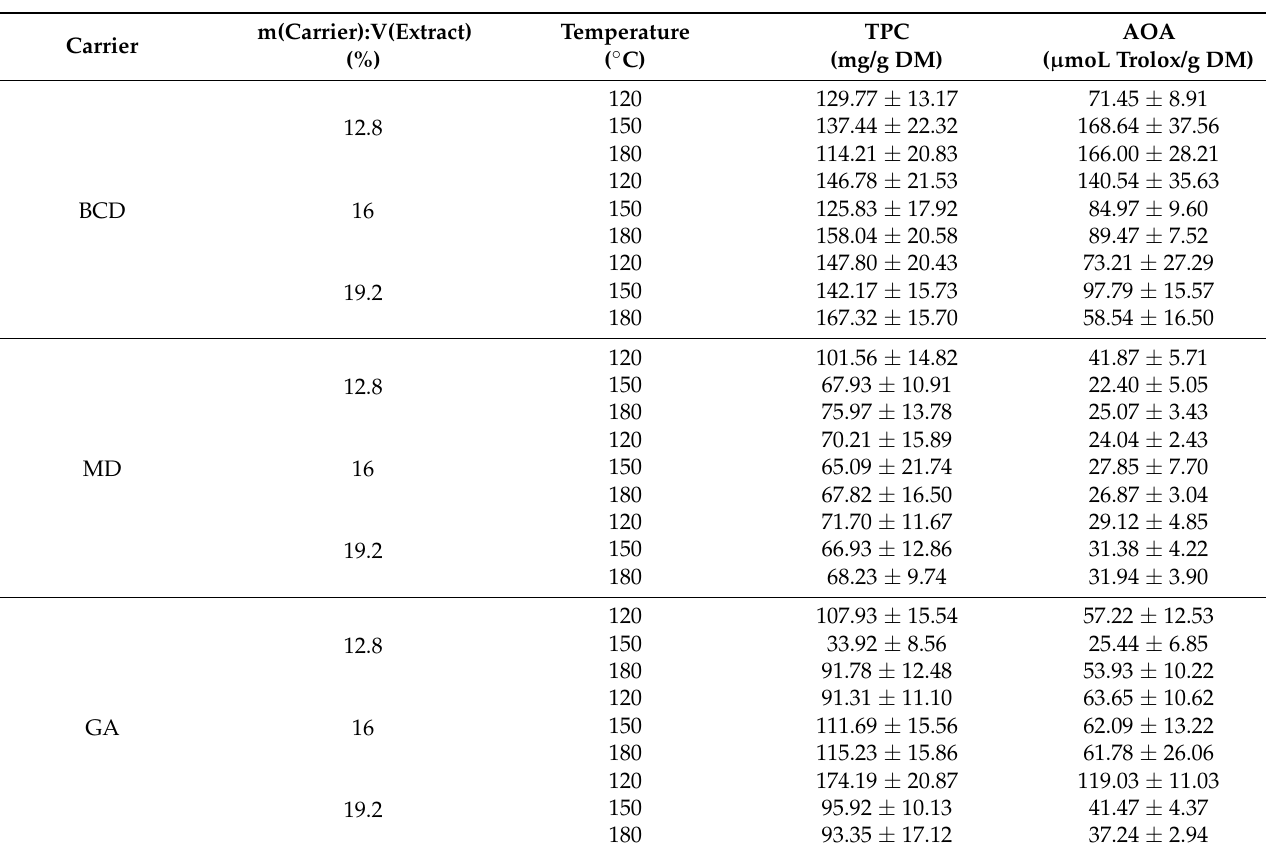
Table 3. Total phenolic content and antioxidant activity of the obtained Pistacia lentiscus leaf ex- tract